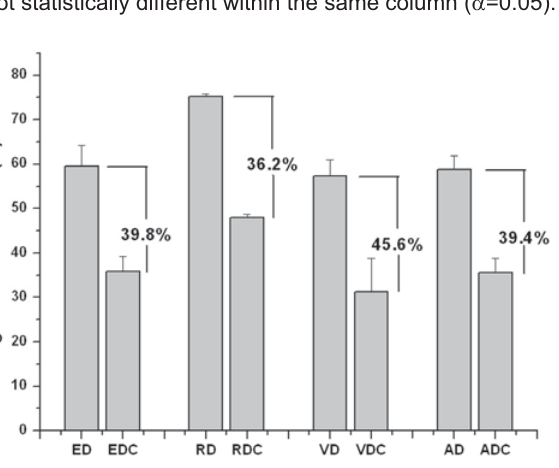
Figure 2- Decrease of DC% for dual activation (D) through the 2.0-mm-thick IPS Empress ceramic disc. E= Enforce; R= Rely X ARC; V= Variolink II; A= All Cem